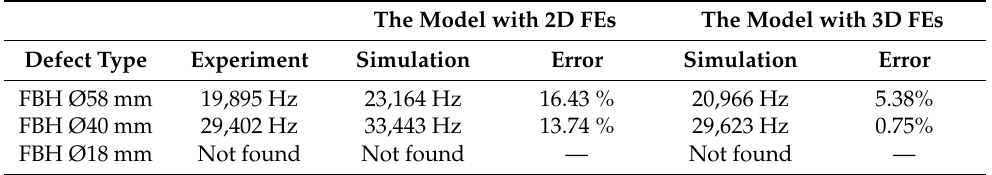
Table 5. Comparison of in-plane LDRs detected by the algorithm for numerical models and experi- ments.